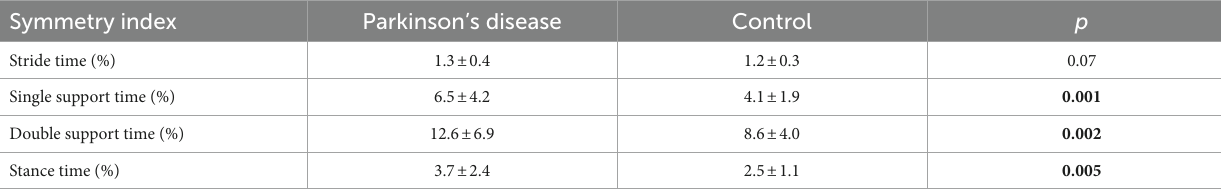
TABLE 3 Symmetry index of the temporal variables for Parkinson’s disease and control groups.